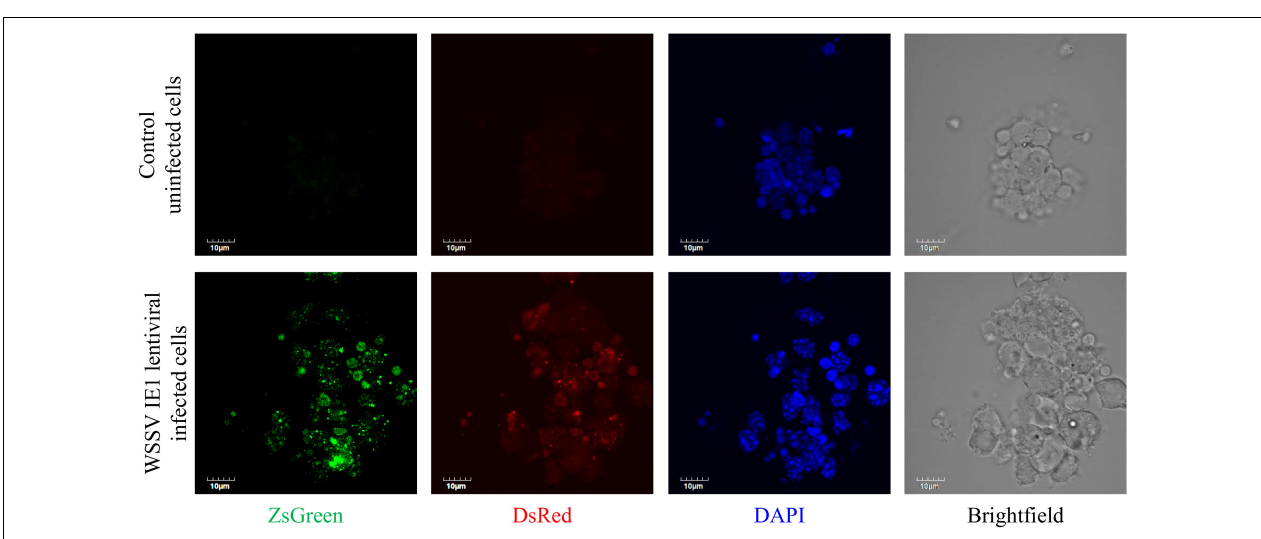
FIGURE 4 | Expression of lentiviral particles in an M. rosenbergii primary cell culture. Representative images of WSSV IE1-infected M. rosenbergii primary cell culture (lower panel) or control uninfected cells (upper panel) grown only in culture medium. Cultures were examined by confocal microscopy (using the appropriate lasers, 488 nm for ZsGreen and 546 nm for DsRed). Nucleic acid staining was performed with DAPI (and visualized with a 405 nm laser). Scale bar = 10 µ m.